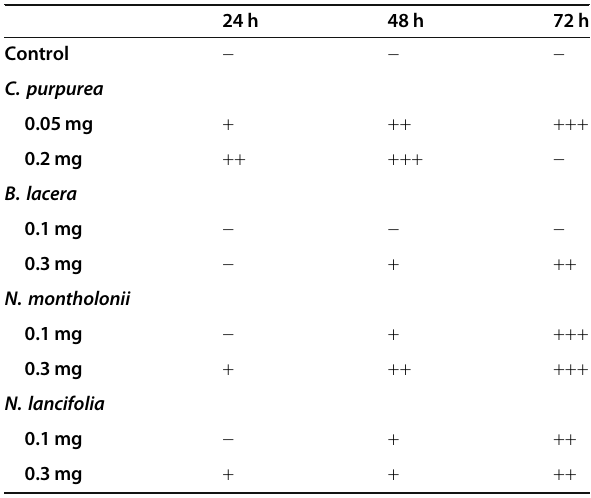
Table 2 Effect of ethanolic extract of Cyathocline purpurea , Blumea lacera , Neanotis montholonii , and N. lancifolia on the midgut of A. aegypti larvae. − sign indicates no effect (or control), while increasing + signs indicate the severity of the treatments as shown in Fig.